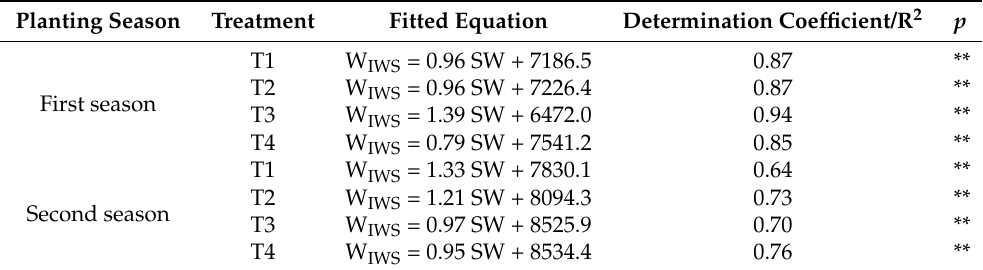
Figure 6. The fitting of SW and W IWS under different water treatments. ( a ) First season, ( b ) sec- ond season. Table 2. Regression analysis of SW and W IWS under different water